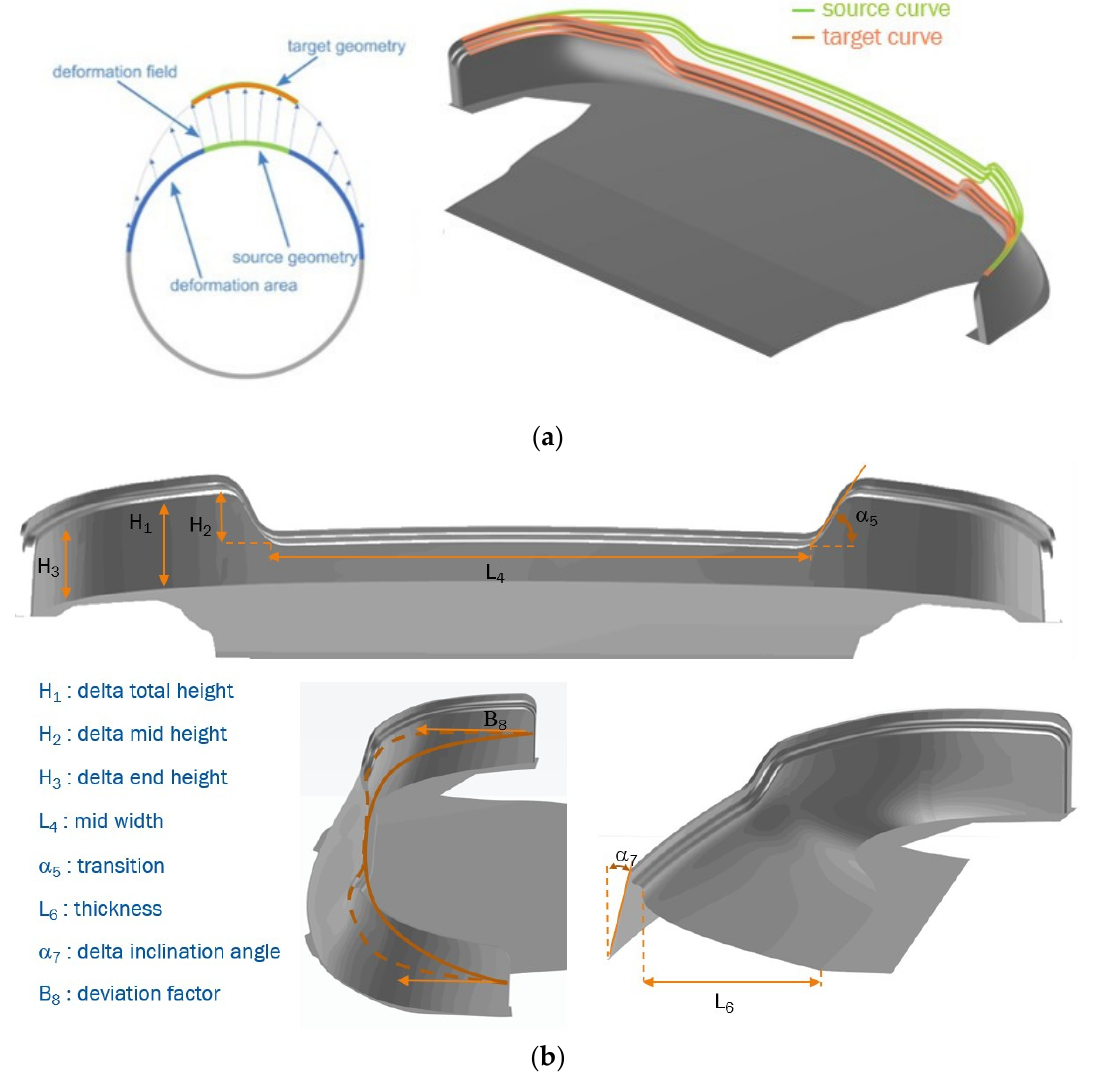
Figure 9. ( a ) Source and target NURBS defined with radius basis functions. The source curve in green corresponds to an absolute total height of the air dam of 280 mm. ( b ) Definition of the design parameters related to the control points.